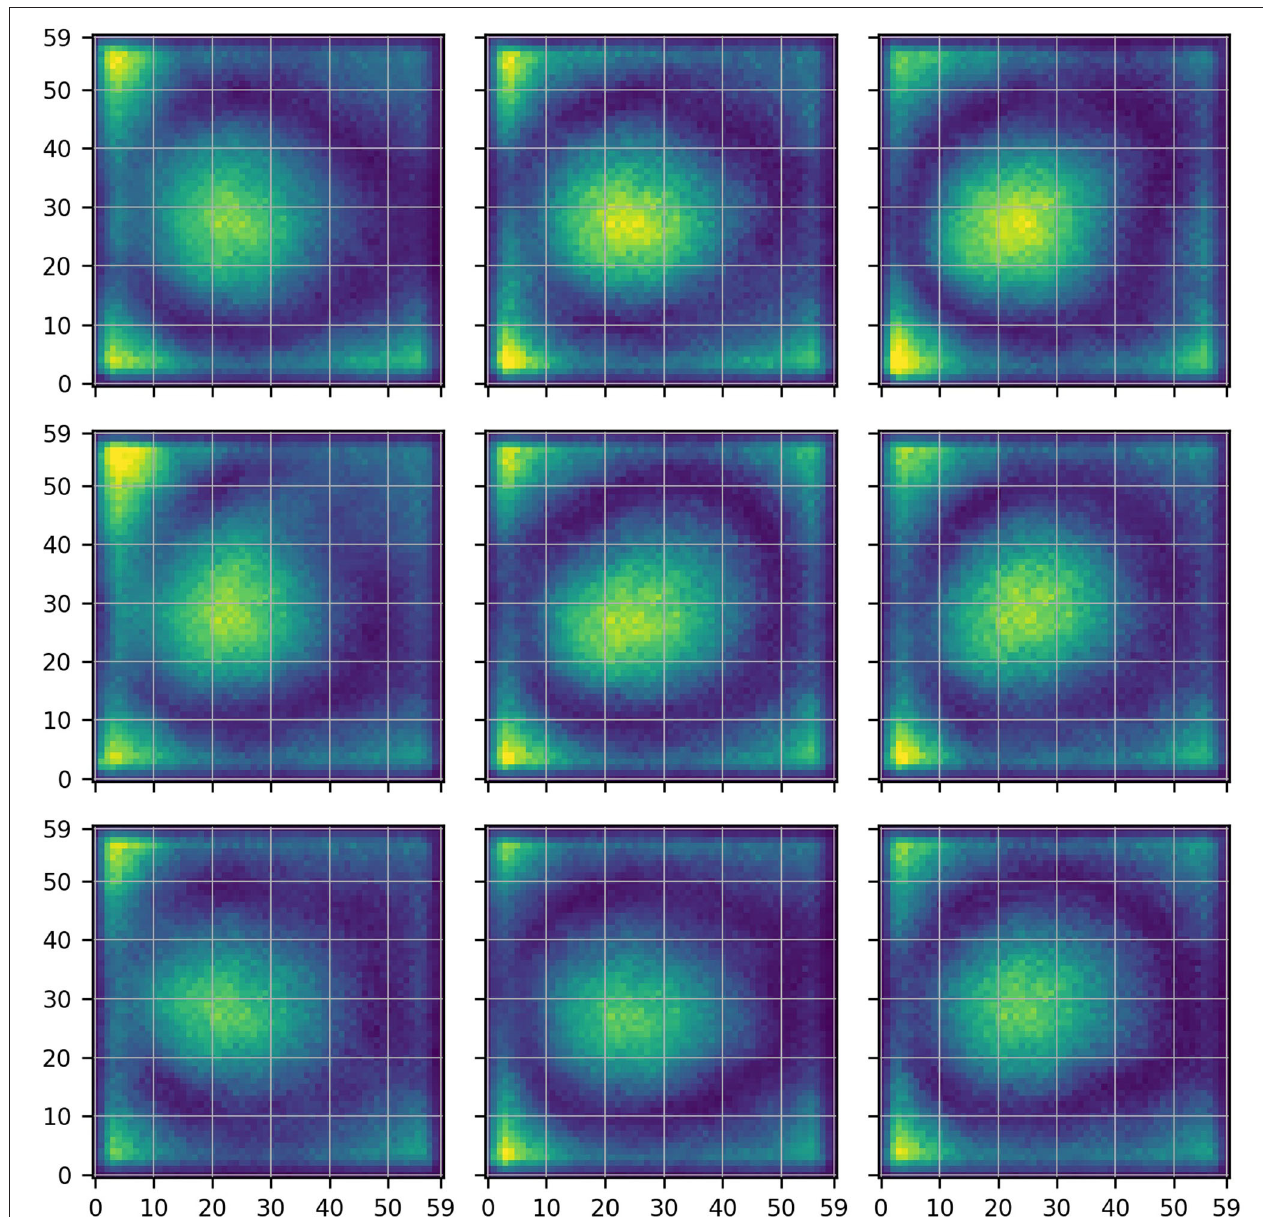
FIGURE 4 | Descriptions obtained when training separate instances of CNN1 for the nine different locations depicted in Figure 2A . Each description is a measure of the average importance of each pixel in the 60 × 60 pixels input region for the predictions of the respective instance of CNN1. Yellow color indicates high and blue color low importance. The central location is the original target location, hence the central description identical to Figure 3A